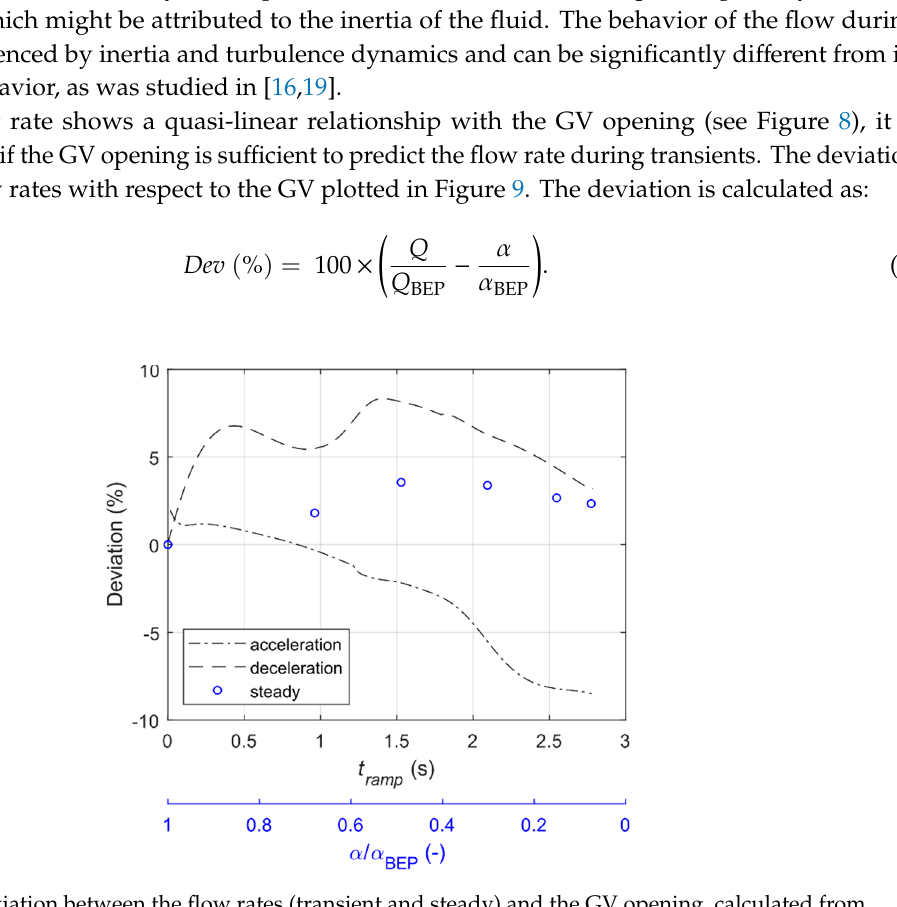
Figure 8. Flow rate variation over time, transient flow rate Q t . ( a ) During an acceleration and ( b ) during a deceleration. The ramp time for the transient, tramp, is 2.77 s. Q s is the steady flow rate obtained from the simulations at stationary GV angle (GVA) ( α ).